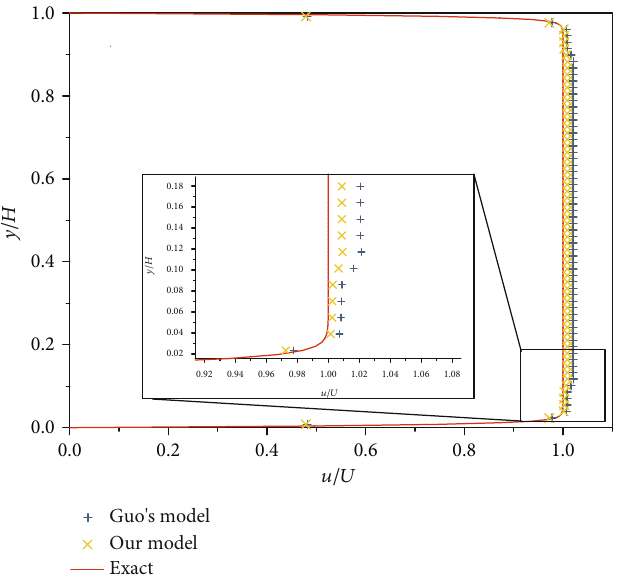
Figure 3: Poiseuille fl ow solved by local grid re fi nement method with two di ff erent velocity